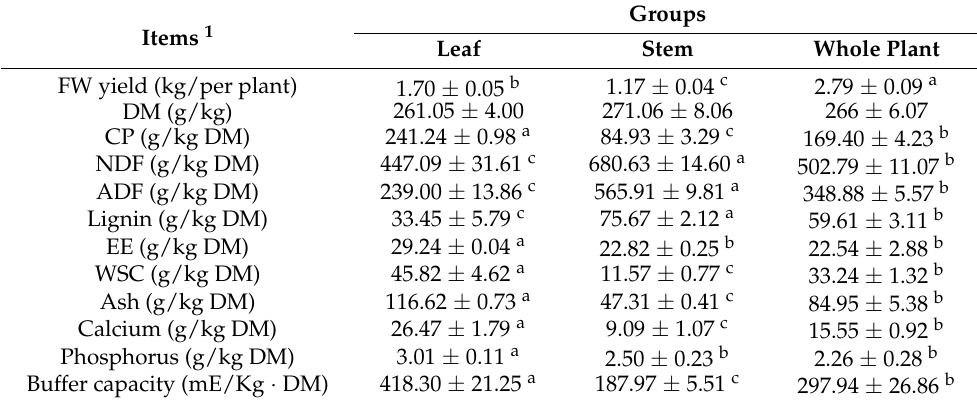
Table 1. Fresh weight yield and chemical composition of different parts of paper mulberry.